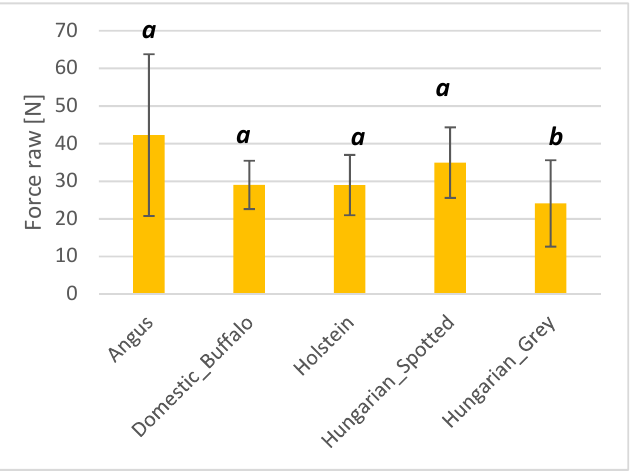
Figure 7. Bar plot showing the measurement of force values of Angus, domestic buffalo, Holstein, Hungarian Spotted, and Hungarian Grey bovine breeds. Different superscripts imply significant differences.